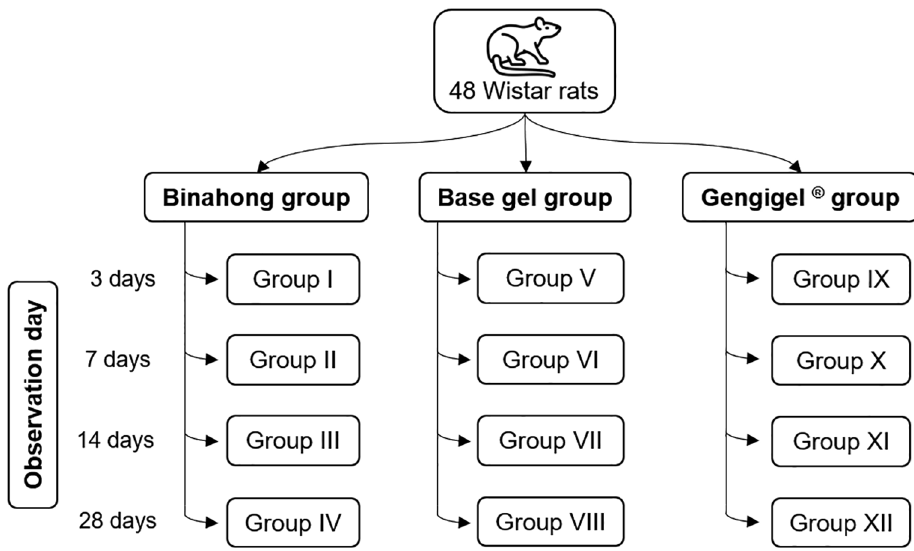
Figure 1. Group allocation; each group is differentiated from one another based on its treatment and observation day and is comprised of four Wistar